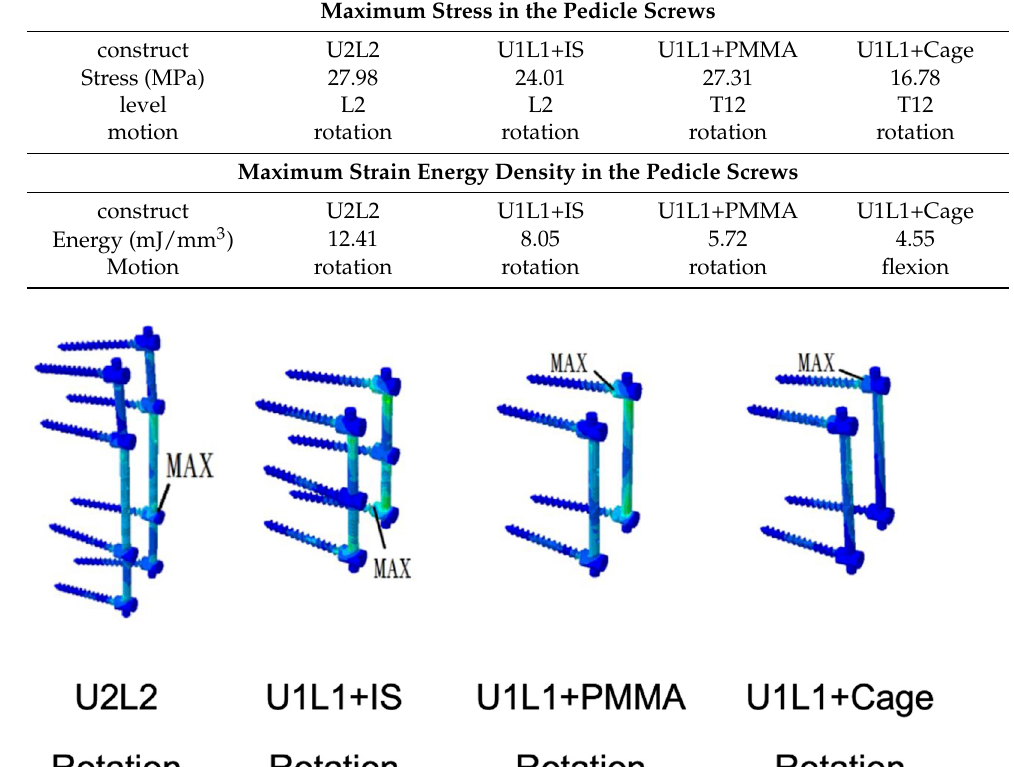
Table 3. Maximum von Mises stress and strain energy in the pedicle screws.